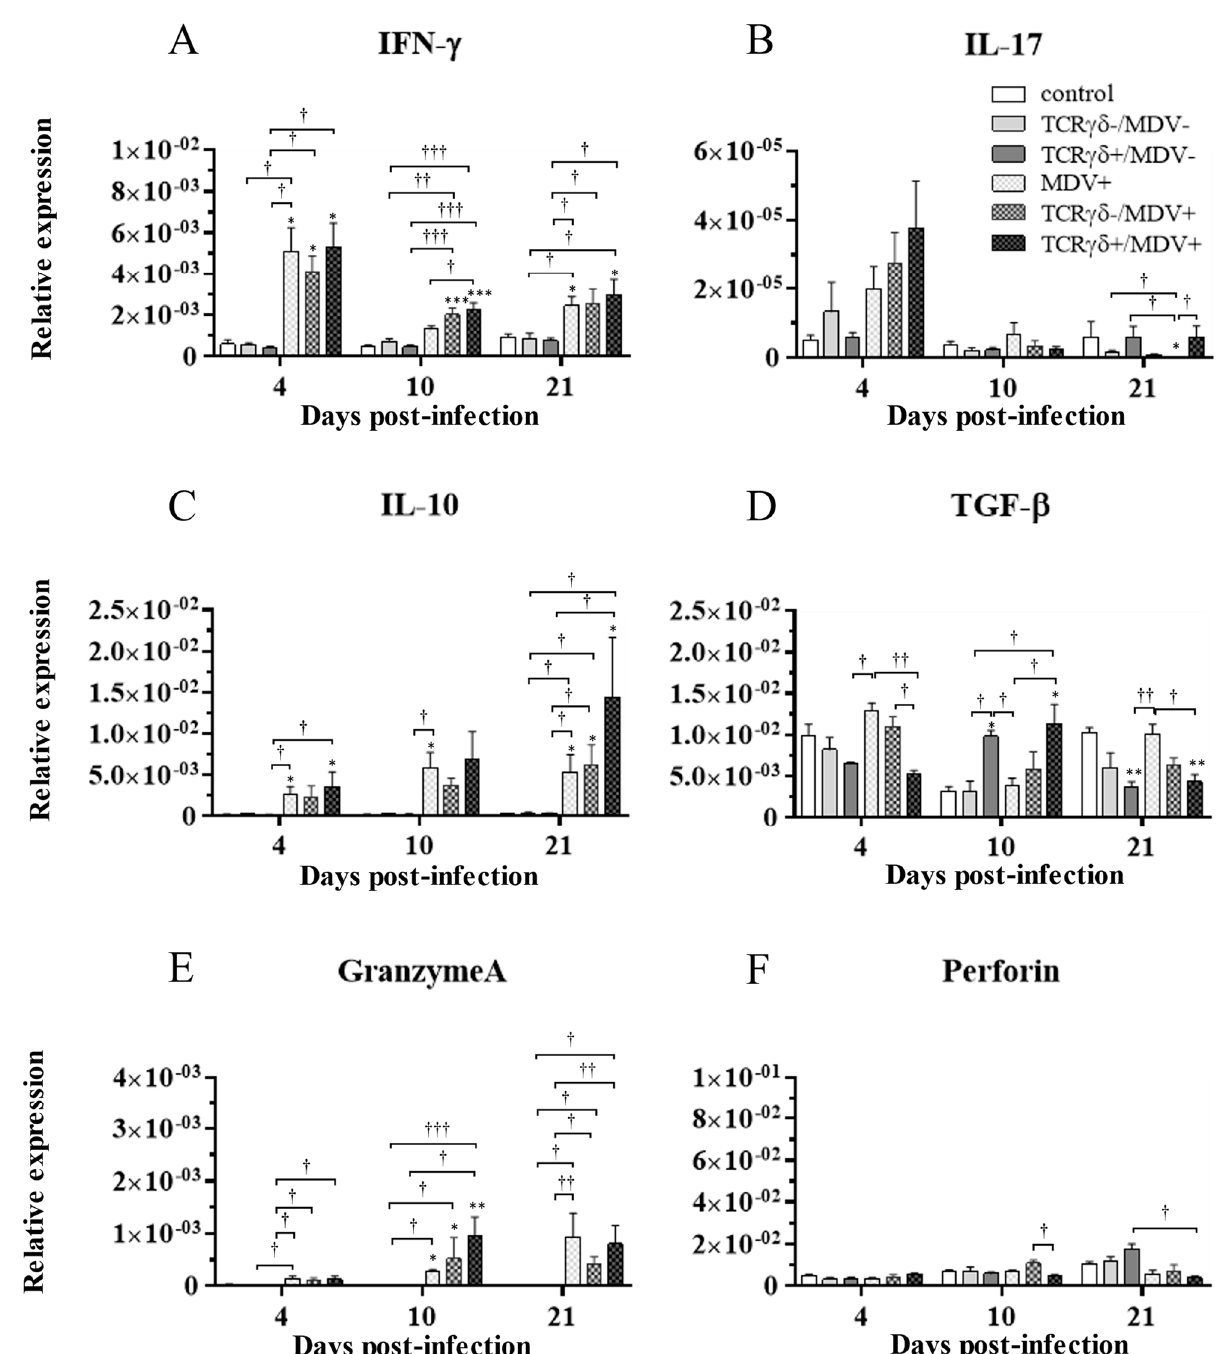
Figure 10. Cytokine, granzyme A, and perforin gene expression profiles in the spleen at 4, 10, and 21 dpi. Gene expression of IFN ‐γ ( A ), IL ‐ 17A ( B ), IL ‐ 10 ( C ), TGF ‐β ( D ), granzyme A ( E ), and perforin ( F ) in the spleen collected from the control, the unstimulated PBMCs control, the TCR γδ‐ /MDV ‐ , the TCR γδ +/MDV ‐ , the MDV+, the TCR γδ‐ /MDV+, and the TCR γδ +/MDV+ groups at 4, 10, and 21 dpi was determined by real ‐ time PCR. Target genes were normalized by β‐ actin. Data represent the mean of 5 biological replicates ± SE in each group at each time point. Significant differences are indicated by *: p < 0.05 (vs. control), **: p < 0.01 (vs. control), ***: p < 0.001 (vs. control), †: p < 0.05, ††: p < 0.01, and †††: p < 0.001.